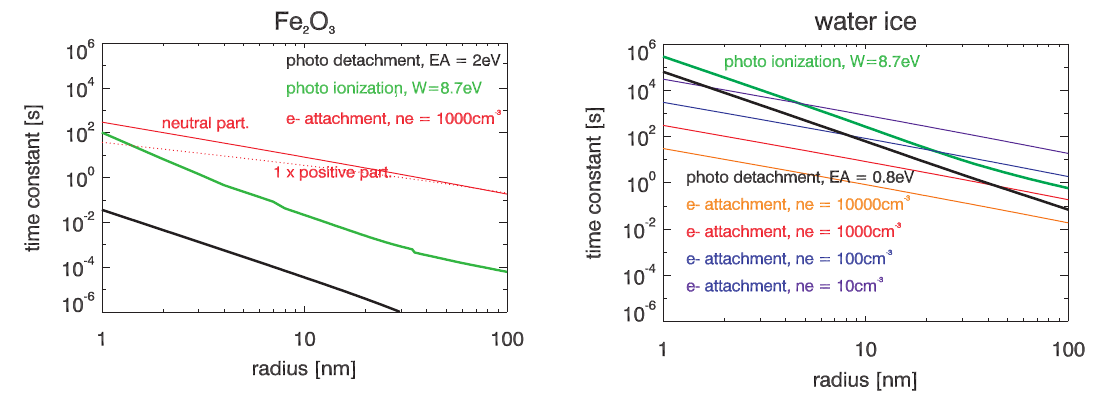
Fig. 2. Left panel: Time constants for photodetachment (in black), photoemission (in green), and electron attachment (red lines) of Fe 2 O 3 - particles as a function of particle radius. Right panel: Time constants for photodetachment (black line), photoemission (in green), as well as electron attachment for electron densities from 10cm − 3 –10000cm − 3 (orange, red, and blue lines) as a function of particle radius.